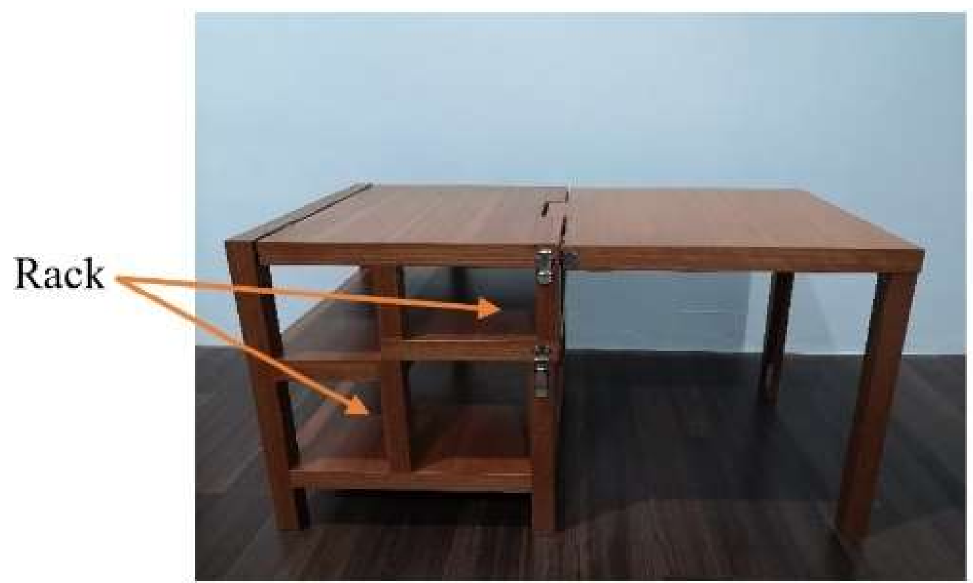
Figure 14. Final prototype—table mode.